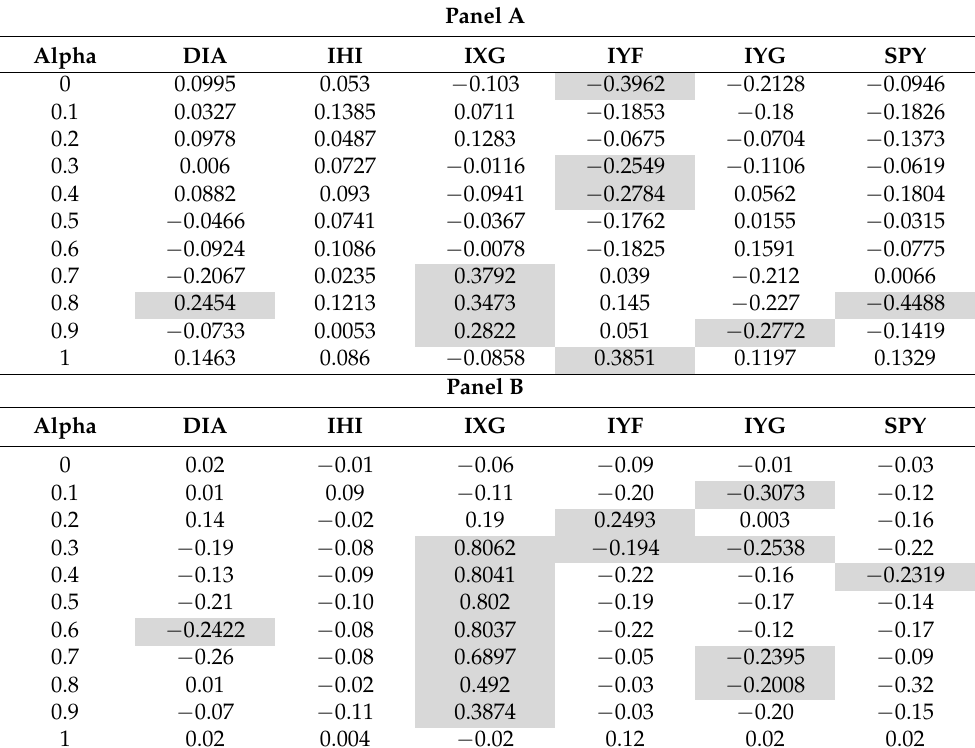
Table 9. Correlation between financial ETFs and VIX for all values of α . Panel A includes data from January 2014 to May 2019, Panel B from January 2014 to May 2020. Significant correlations (5% significant level) are highlighted in